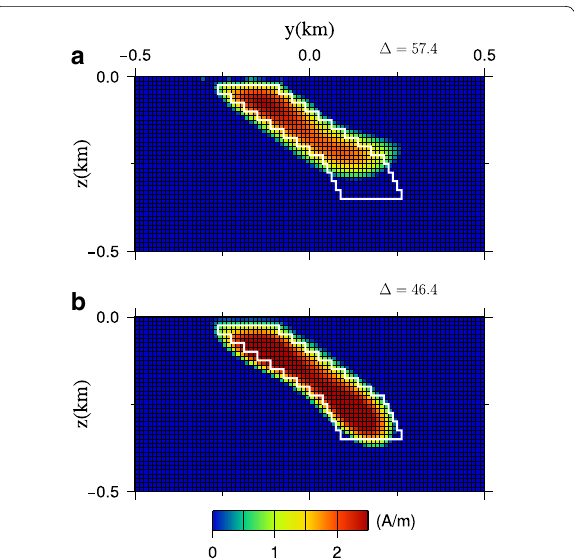
Fig. 19 Cross-section of the models. Cross-section of the models α S 1 0.96 using weighting function w S 1 , and b with a ˆ = using w S 2 . White line indicates the location of the magnetized slab of the true model. On the upper right of each panel, the value of (cid:31) is